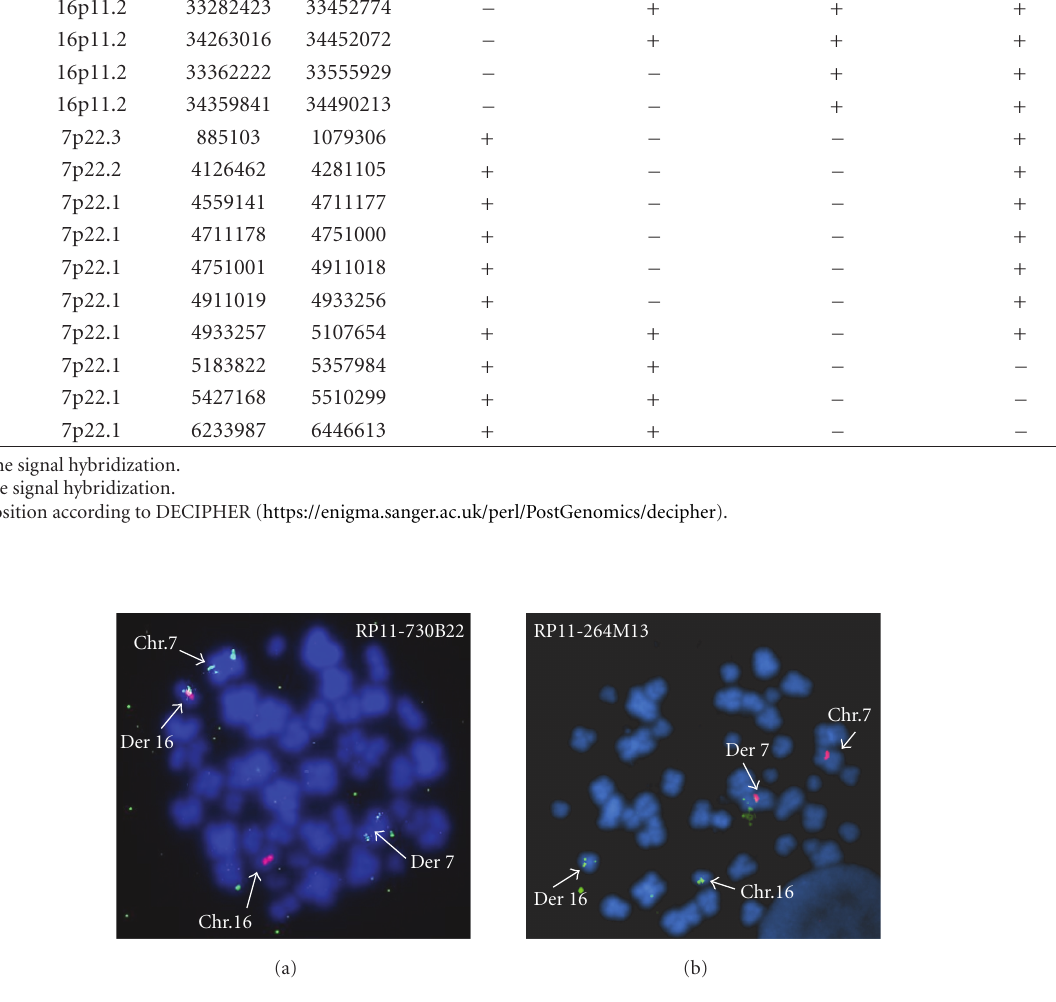
Figure 3: FISH analysis of the translocation breakpoints: (a) FISH analysis with the BAC RP11-730B22 (green) located in 7p22.1 and a centromeric probe of chromosome 16 (red), shows that this BAC is spanning the breakpoint on chromosome 7. (b) FISH analysis with BACs RP11-264M14 (green) showed that it spans the translocation breakpoint located on 16p11.2. It was hybridised with a chromosome 7 centromeric probe (red). (Chr.: chromosome, Der.: